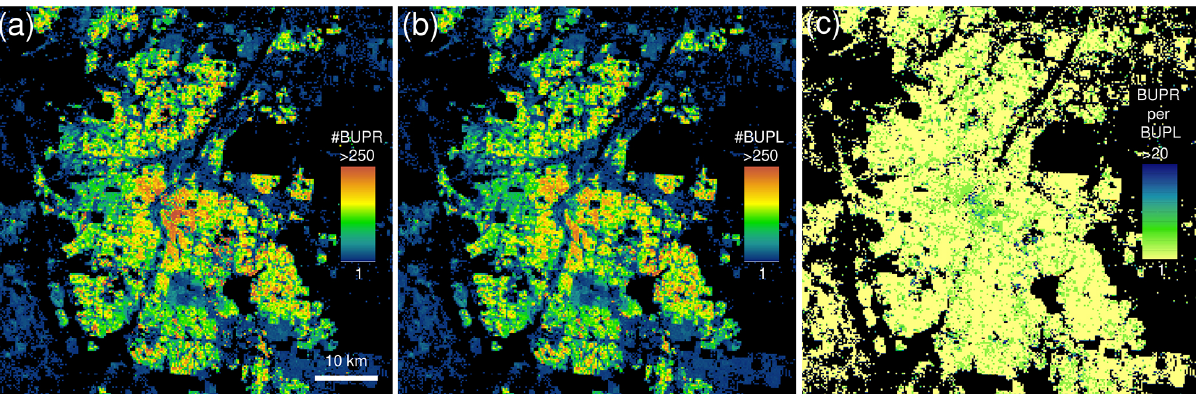
Figure 2. Comparison of (a) built-up property records, and (b) built-up property location surfaces, shown for Denver, Colorado; (c) cell- by-cell ratio surface (i.e. built-up property records per built-up property location) highlighting the presence of structures of multi-address or multi-owner records, representing large and high-rise office or apartment buildings or